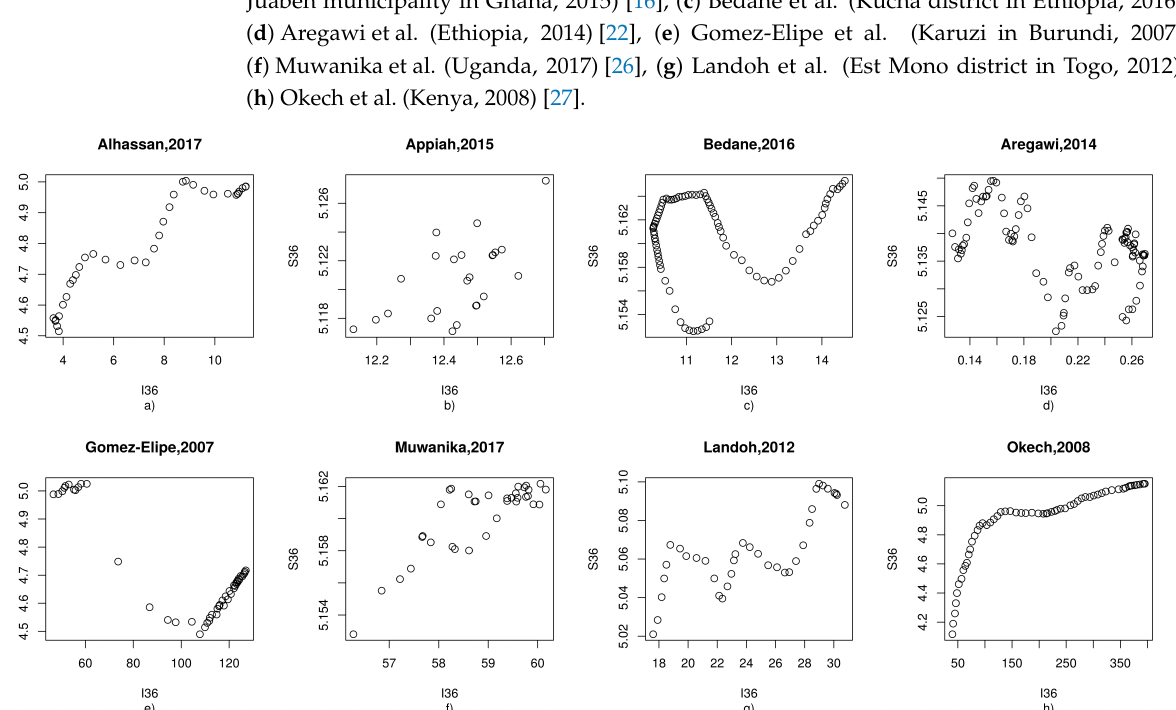
Figure A2. Illustration of how 36-month moving average malaria incidence in the x -axis, symbolized as I 36 relates to 36-months entropy S 36 in th y -axis in malaria empirical time series: ( a ) Alhassan et al. (Kasena Nankana municipality in Ghana, 2017) [21]. ( b ) Appiah et al. (Ejisu-Juaben municipality in Ghana, 2015) [16], ( c ) Bedane et al. (Kucha district in Ethiopia, 2016) [23], ( d ) Aregawi et al. (Ethiopia, 2014) [22], ( e ) Gomez-Elipe et al. (Karuzi in Burundi, 2007) [24], ( f ) Muwanika et al. (Uganda, 2017) [26], ( g ) Landoh et al. (Est Mono district in Togo, 2012) [25], ( h ) Okech et al. (Kenya, 2008) [27]. Alhassan (2017)